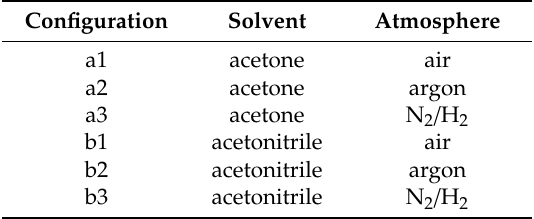
Figure 4. EDX line-scan of Fe 50 Rh 50 nanoparticles synthesized in acetone under ( a1 ) air, ( a2 ) argon, ( a3 ) N 2 /H 2 mixture atmosphere and in acetonitrile under ( b1 ) air, ( b2 ) argon, ( b3 ) N 2 /H 2 mixture atmosphere. Panel ( c ) depicts the extracted oxygen fraction for the different configurations. Table 1. Configuration of solvent and atmosphere during LAL.